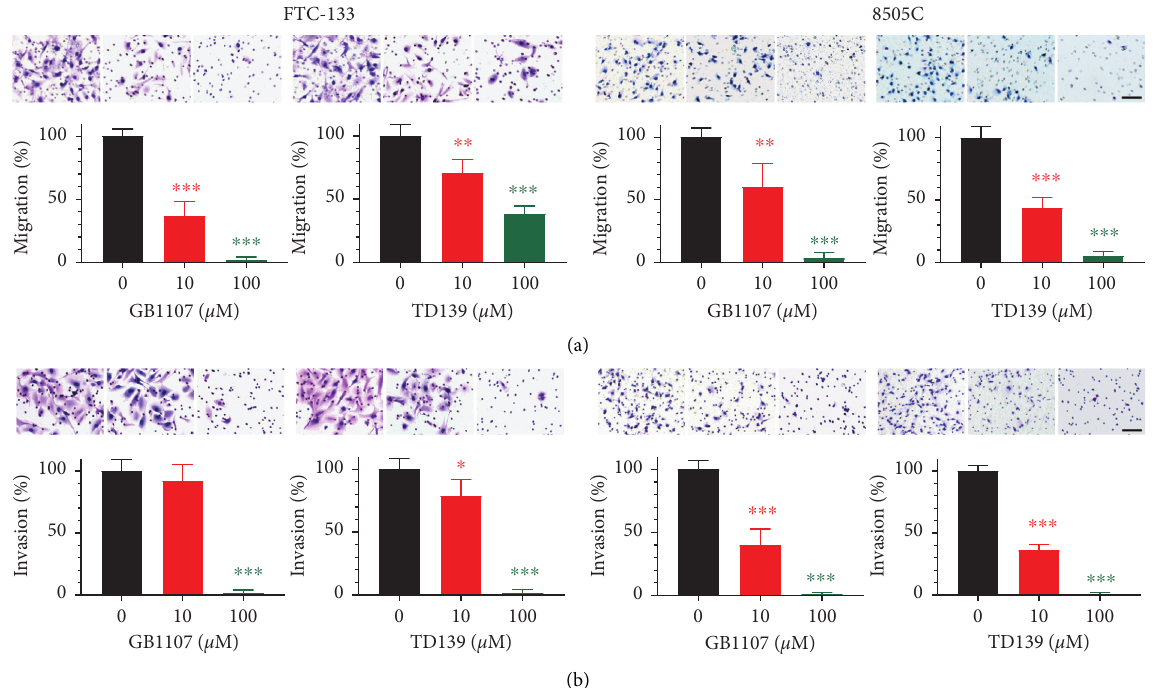
Figure 4: Effects of galectin-3 inhibitors (GB1107 and TD139) on cell migration and invasion in FTC-133 and 8505C human thyroid cancer cells. (a) Cells were allowed to migrate through Transwell chambers in the presence of GB1107 or TD139 for 24h. (b) Cells invading through Matrigel-coated Transwell chambers with or without 24h GB1107 and TD139 treatment were fixed and quantified. Scale bars, 100 μ m. ∗ p < 0 . 05, ∗∗ p < 0 . 01, ∗∗∗ p < 0 . 001.